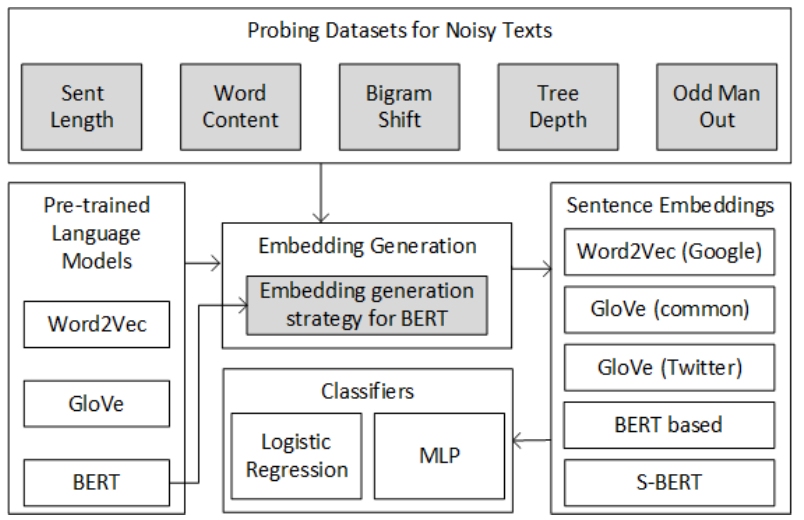
Figure 2. Sentence embedding evaluation framework. For the proposed work, we study BERT for embedding generation. This framework can be easily extended to study other pre-trained language